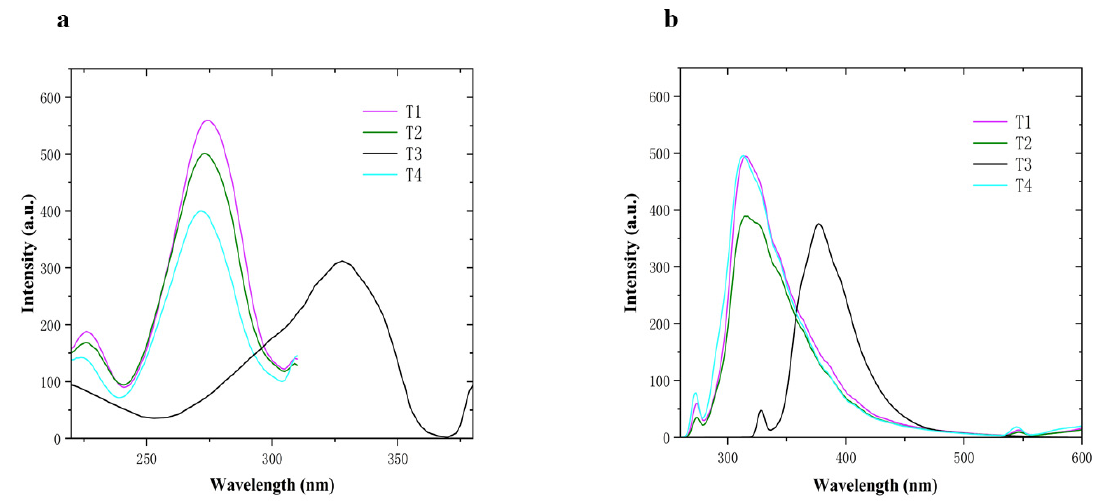
Figure 4. ( a ) The excitation wavelengths of T1 – T4 ( b ). The emission wavelengths of T1 – T4